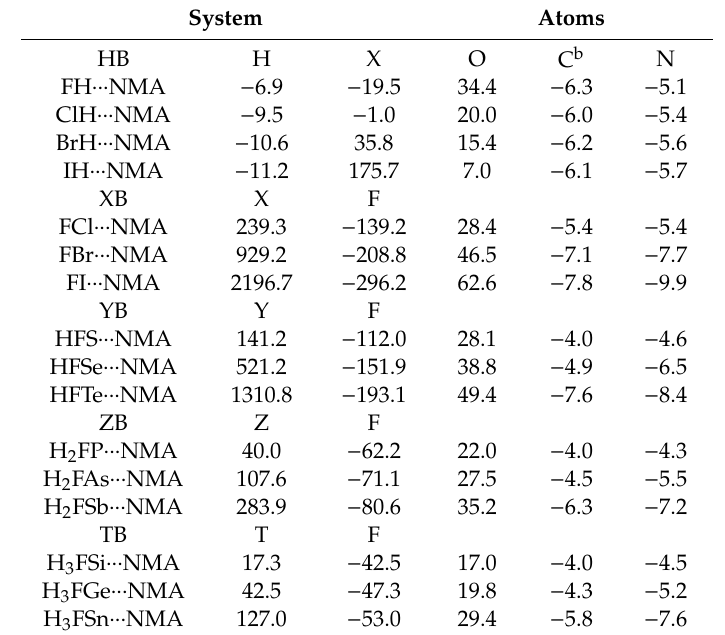
Table 2. Changes of NMR chemical shielding (ppm) caused by complexation a